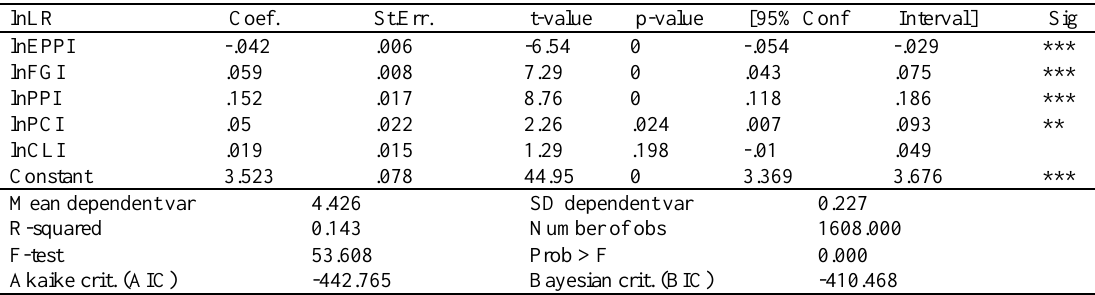
Table 2: Ordinary Least Square (OLS) model